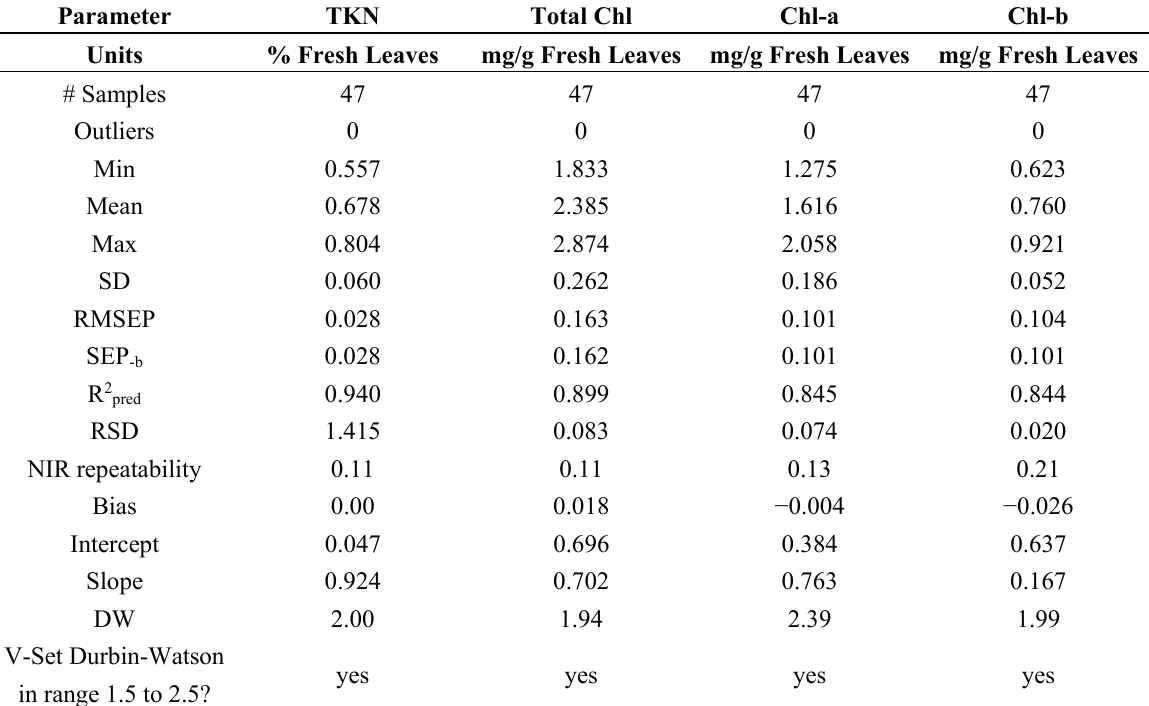
Figure 3. Comparison between NIR-predicted and measured values for TKN concentration ( A ); and chlorophyll content calculated as total (closed squares) and as the sum of Chl-a and Chl-b (open squares) ( B ). Table 3. Statistics of validation during external